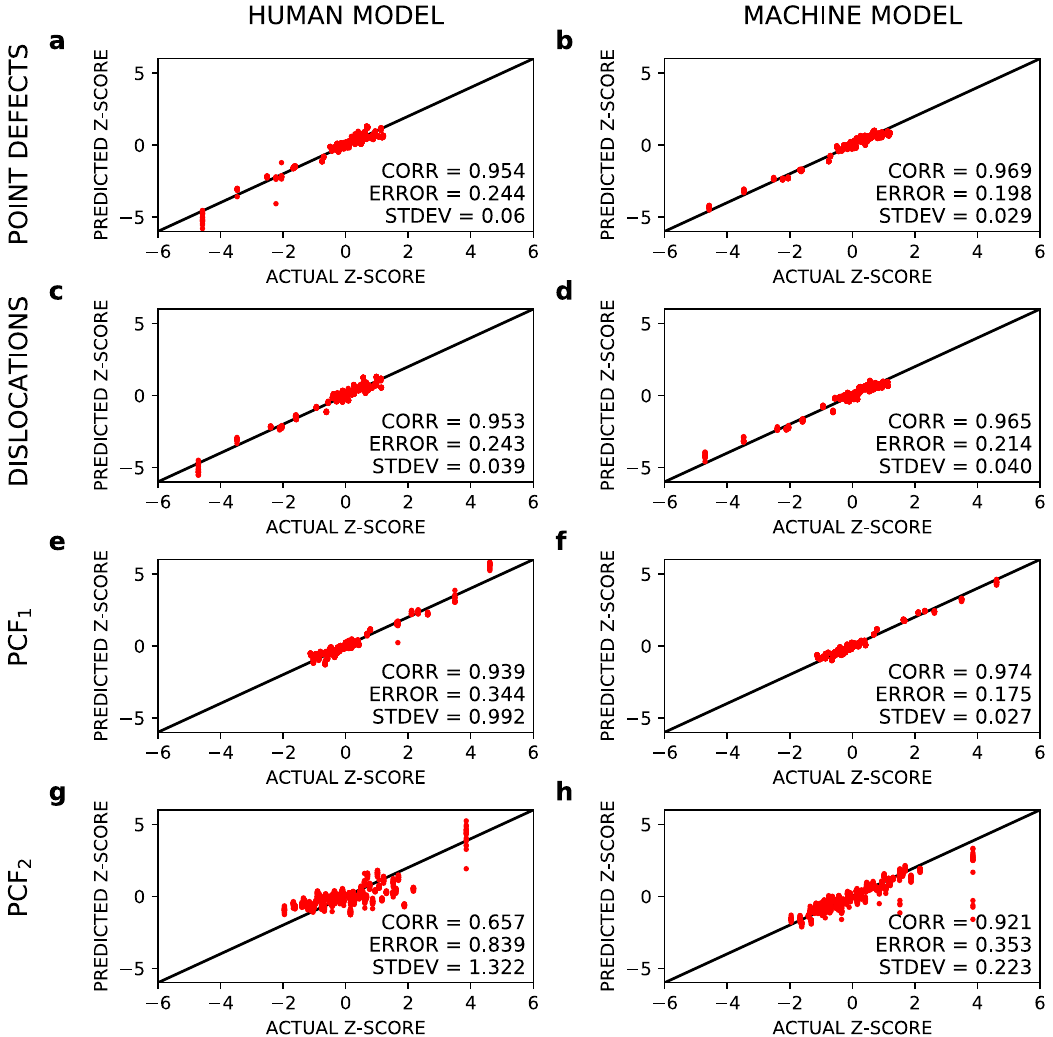
function (PCF) of the point-defect distribution ( e – h ). The black line is the y = x reference. The Pearson correlation coef fi cient (CORR), root- mean-squared error (ERROR), and standard deviation (STDEV) as compared to that reference line are